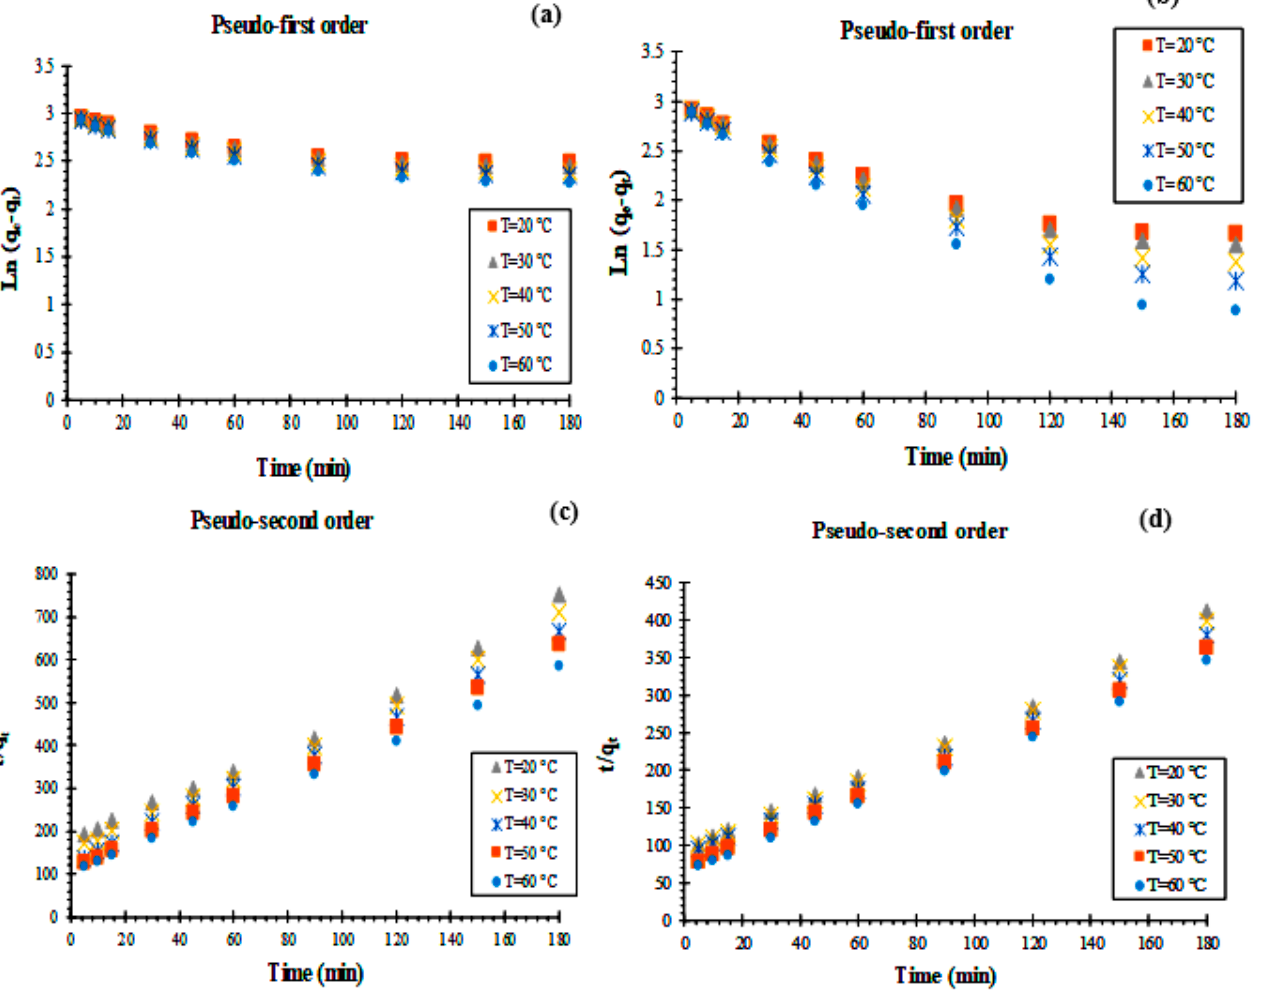
Figure 10. Pseudo ‐ first ‐ order and pseudo ‐ second ‐ order models plot for RhB at different tempera ‐ Figure 10. Pseudo-first-order and pseudo-second-order models plot for RhB at different temperatures tures onto ( a , c ) KS44 ‐ 0 and ( b , d ) KS44 ‐ 20. onto ( a , c ) KS44-0 and ( b , d ) KS44-20.